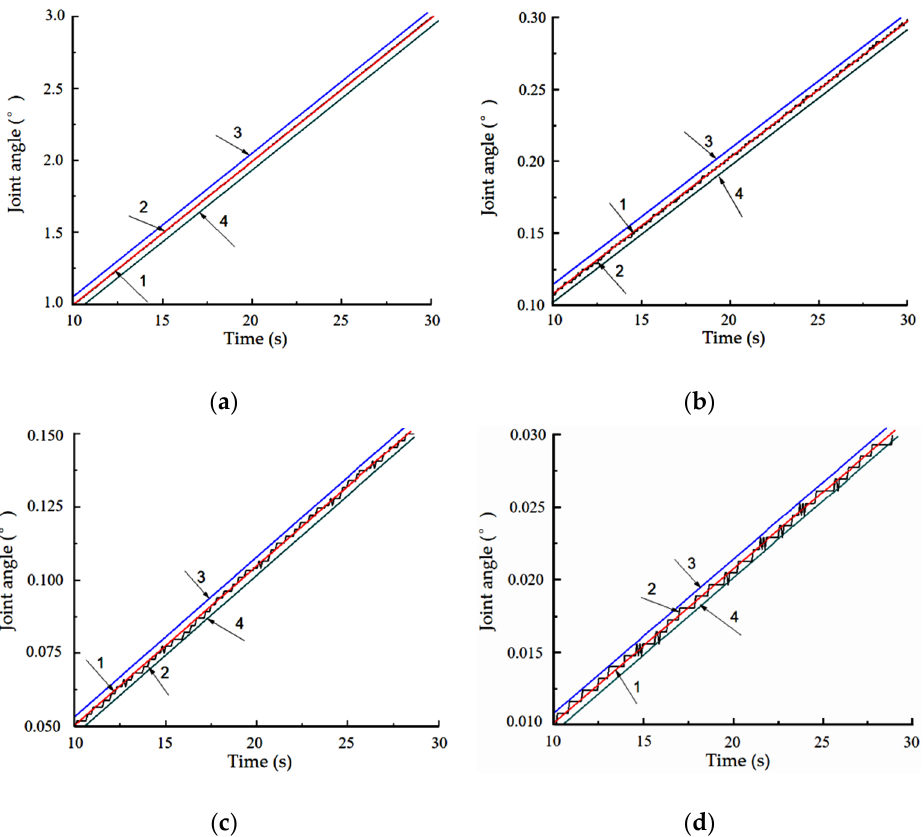
Figure 13. Angular position curves with different velocity without friction compensation control. ( a ) angular position curve with a velocity of 0.1 ◦ / s; ( b ) angular position curve with a velocity of 0.1 ◦ / s; ( c ) angular position curve with a velocity of 0.005 ◦ / s; ( d ) angular position curve with a velocity of 0.001 ◦ /